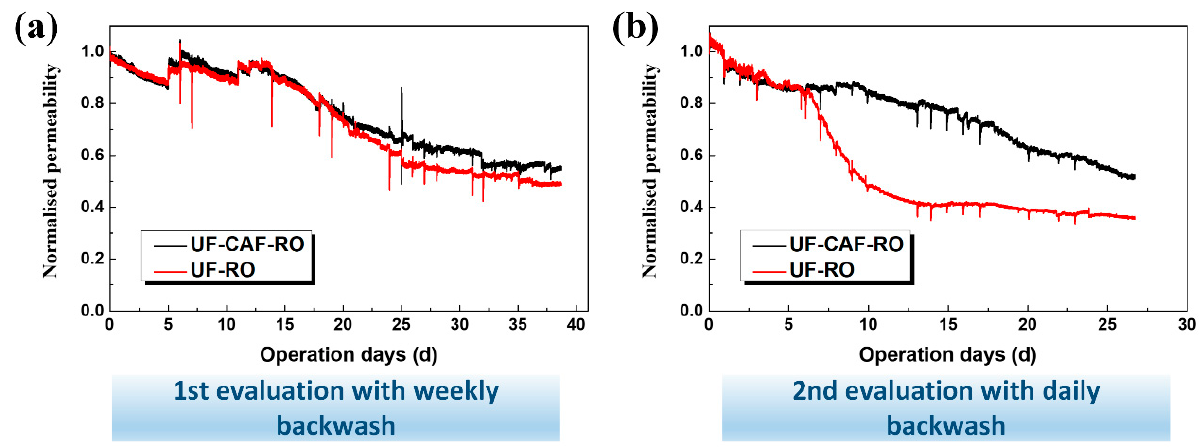
Figure 4. Evolution of the normalized permeability of RO membranes with and without CAF treat- ment.